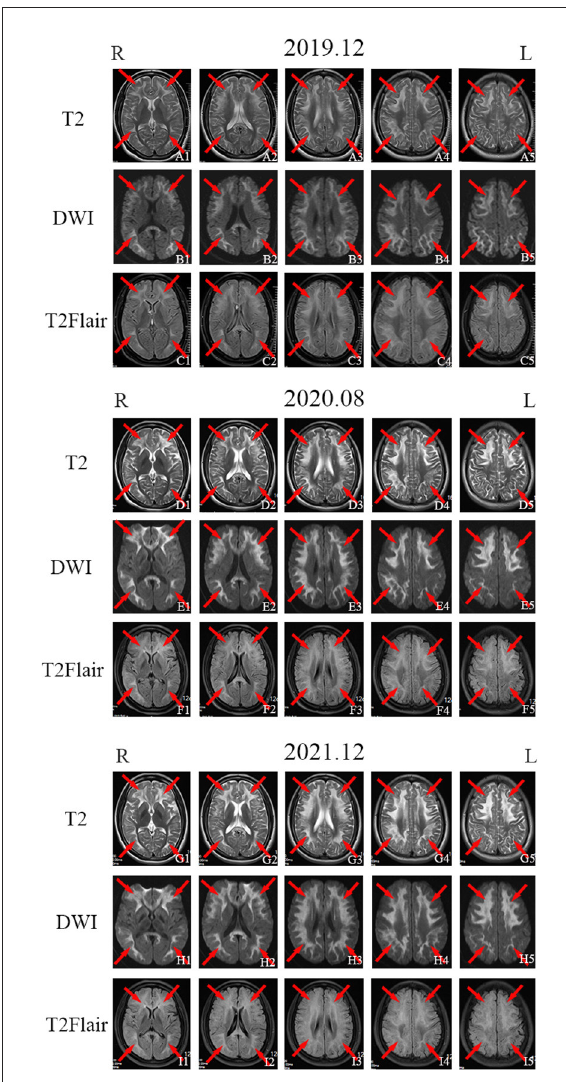
FIGURE2 Imaging examination of patient 2. Head magnetic resonance imaging (MRI) in November 2019 showed bilateral and relatively symmetrical ribbon signs with high-intensity signals along the corticomedullary junction of the frontotemporal-parietal lobes and corpus callosum on T2-weighted imaging, diffusion-weighted imaging (DWI), and T2 fluid-attenuated inversion recovery (FLAIR) sequence [ (A1–A5) , (B1–B5) , and (C1–C5) ; red arrows]. Head MRI in August 2020 [ (D1–D5) , (E1–E5) , and (F1–F5) ; red arrows] and December 2021 [ (G1–G5) , (H1–H5) , and (I1–I5) ; red arrows] showed the same high signal along the corticomedullary junction of the frontotemporal-parietal lobes and corpus callosum on T2-weighted imaging, DWI, and T2 FLAIR sequences as were observed in November 2019.